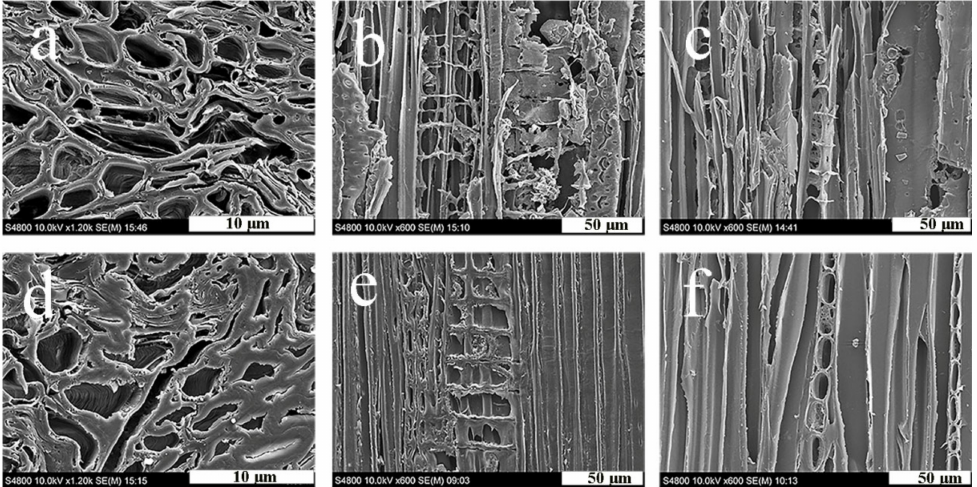
Figure 6. SEM images of ( a – c ) untreated WFMRC and ( d – f ) VI WFMRC after 12 weeks of incubation with T. versicolor fungi: ( a , d ) transverse section; ( b , e ) radial section; and ( c , f ) tangential